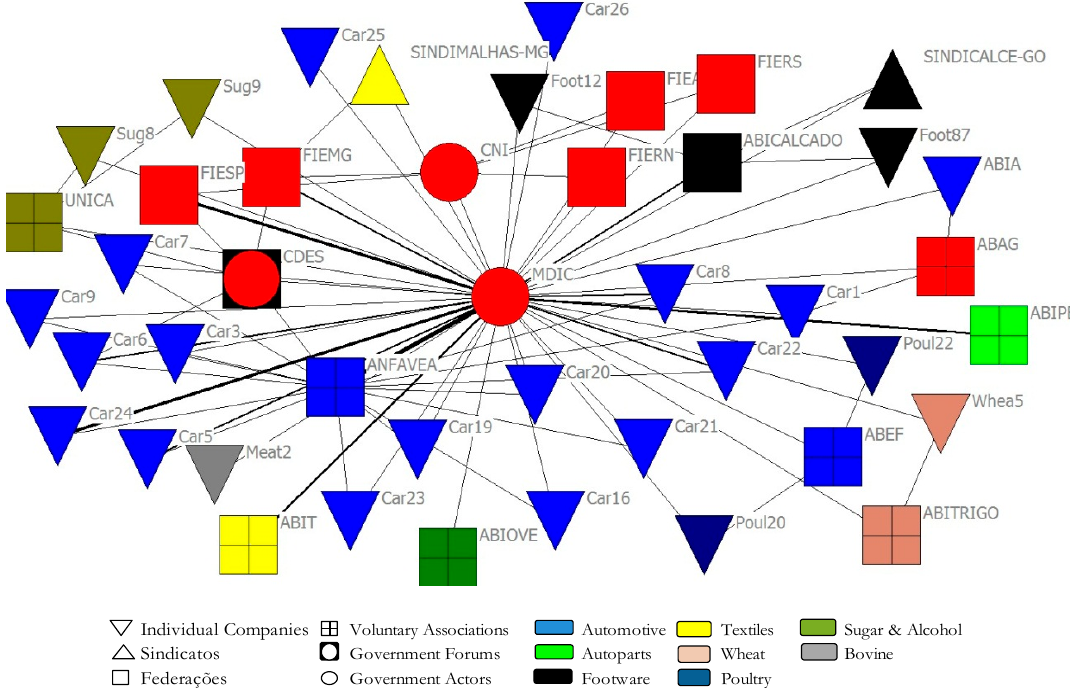
Figure 6. Direct ties among the Ministry of Development (MDIC), business associations, and companies (geodesic distance = 1).